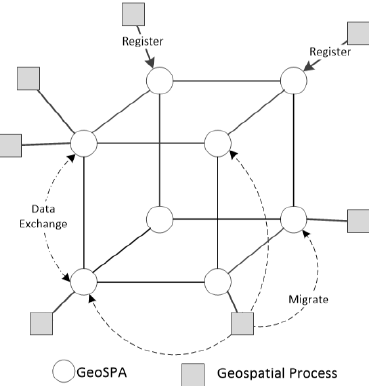
Figure 2. Illustration of Hypercube topology with